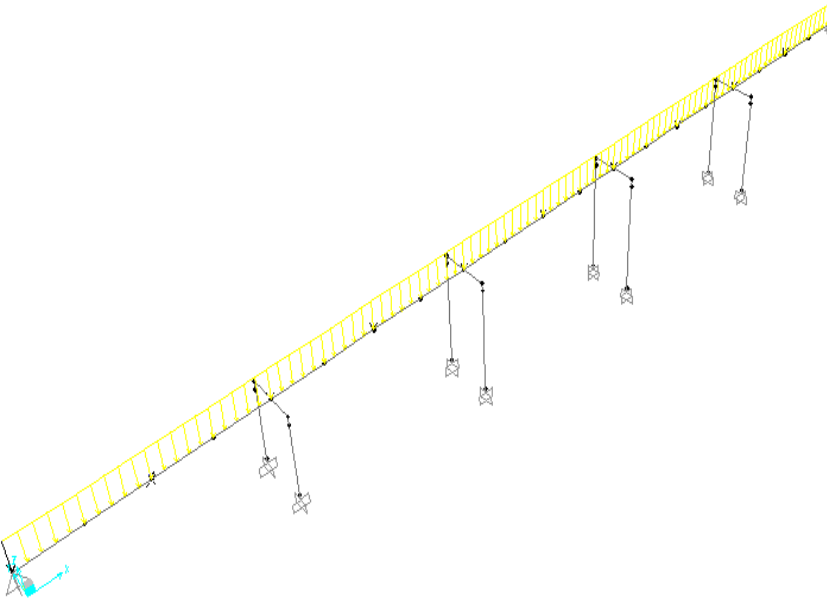
Figure 4. SAP2000 model of the bridge.